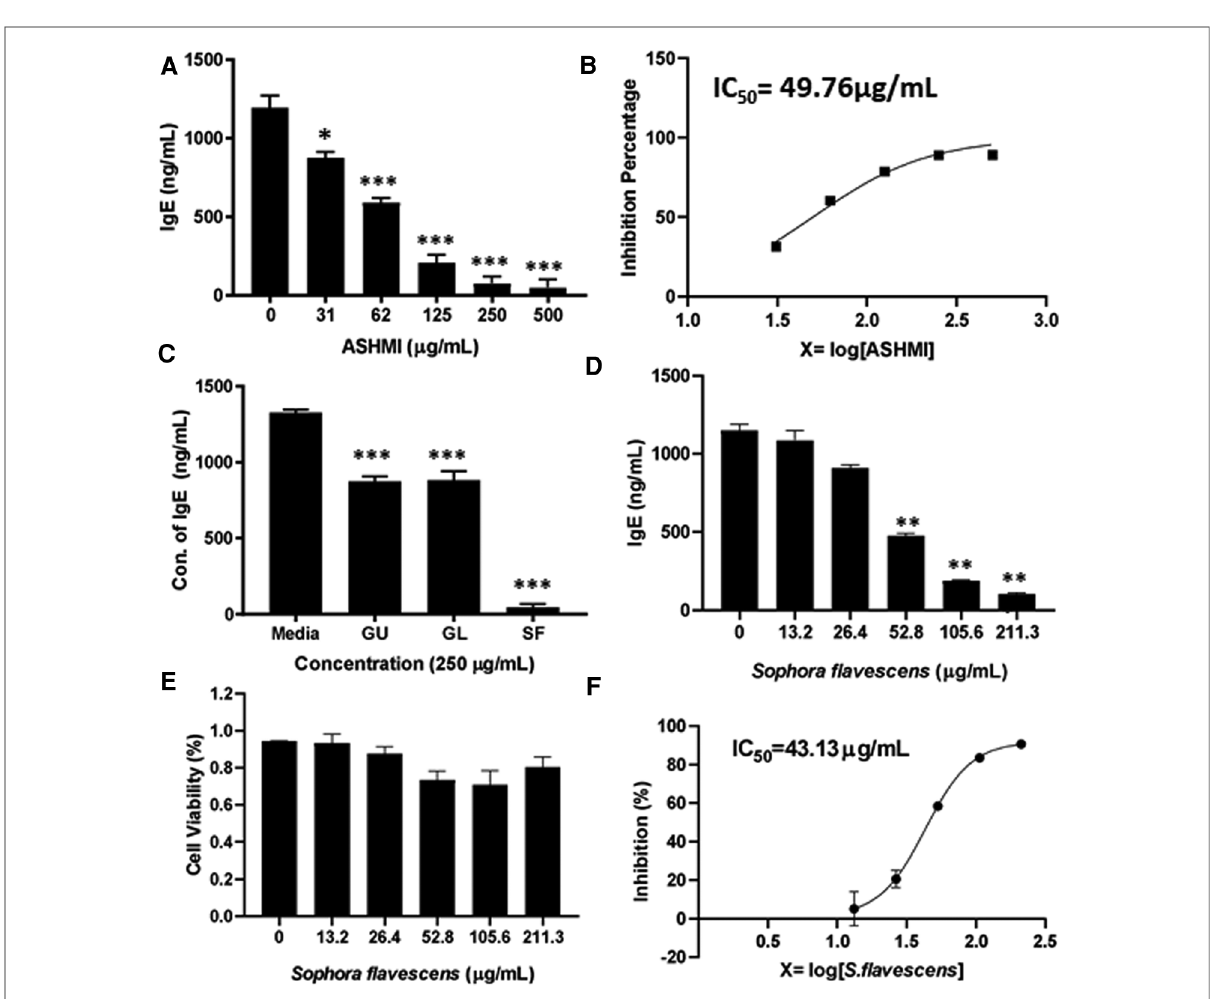
FIGURE 1 Dose-dependent effect of ASHMI formula and its herbal constituents on IgE production in U266 cells. ( A ) Inhibitory effect of ASHMI formula on IgE production by U266 cells. ( B ) Percentage of IgE inhibition vs. log [ASHMI concentration] curve. ( C ) Inhibitory effect of individual herbal constituents of ASHMI on IgE production at 250 µg/ml. ( D ) Inhibitory effect of Sophora fl avescens on IgE production in vitro . ( E ) Cell viability of Sophora fl avescens on U266 cells. ( F ) Percentage of IgE inhibition vs. log [ Sophora fl avescens concentration] curve. U266 cells (2×10 5 cells/ml) were cultured with ASHMI and individual herbal constituents at concentrations as indicated for 6 days. The supematants were harvested and IgE levels were measured by ELISA. Results were expressed as the mean±SD. * p <0.05; ** p <0.01; *** p <0.001. Data represents triplicate